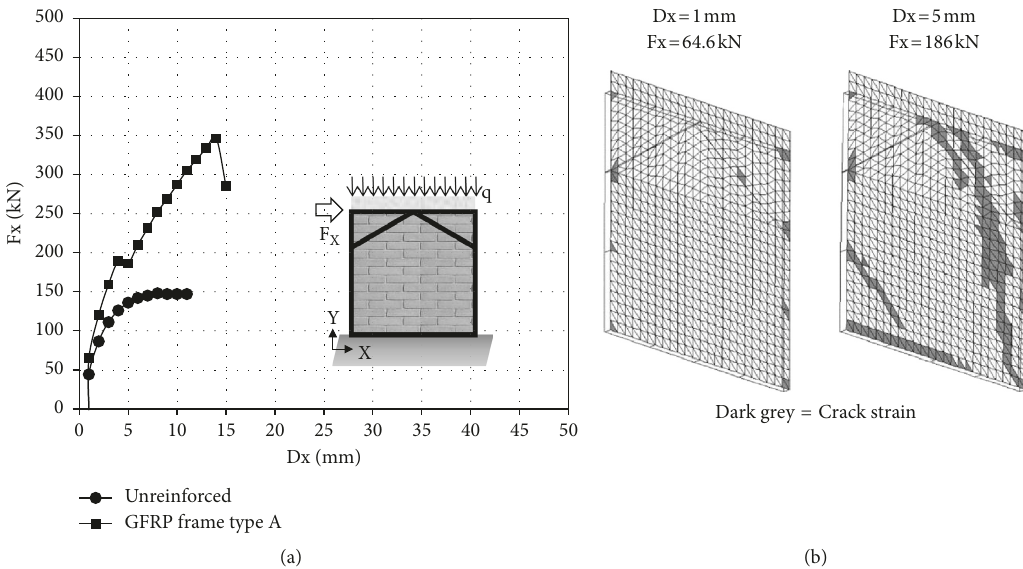
Figure 1: Output of preliminary FE global model: (a) load-displacement graph; (b) crack pattern.